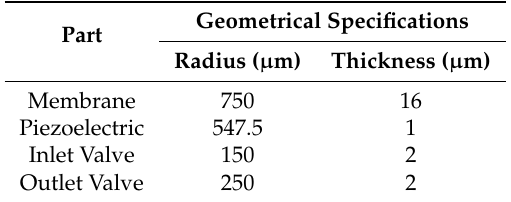
Table 3. The geometrical specifications of the solid